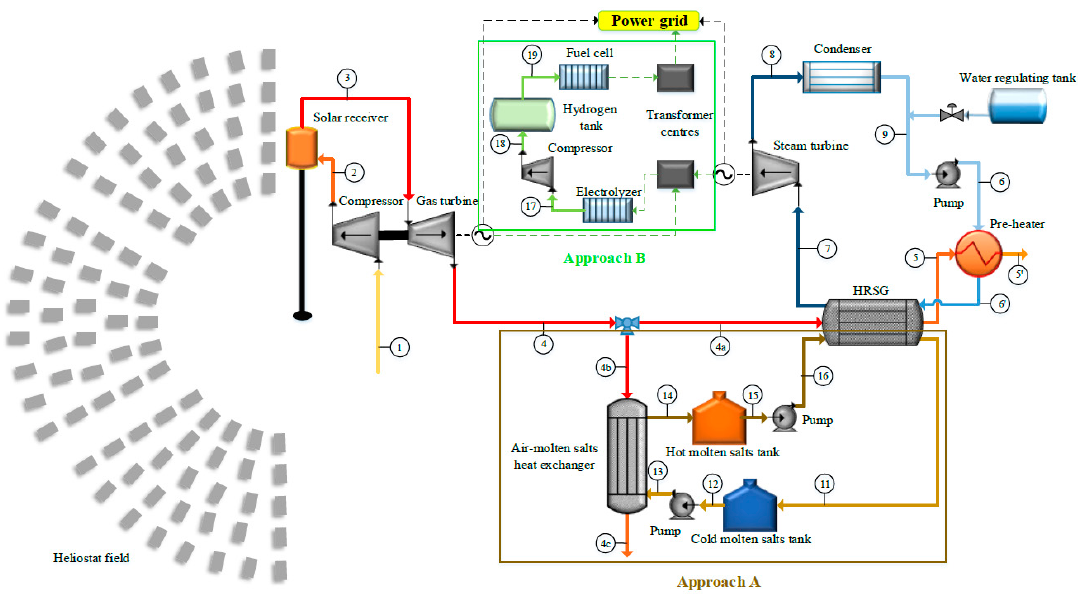
Figure 1. Integrated Solar Combined Cycle (ISCC) power plant layout coupled to two different energy storage approaches.